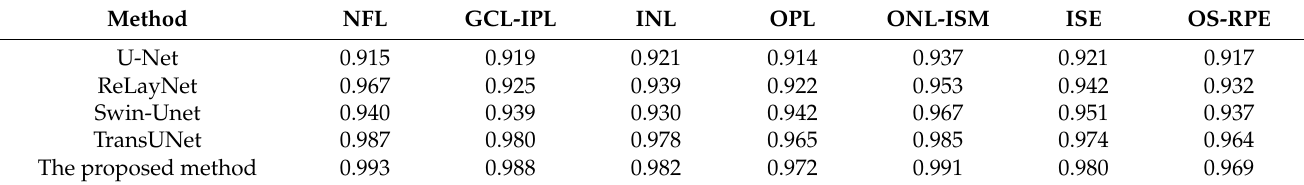
Table 3. Comparison of AUC values of different methods in different layers.